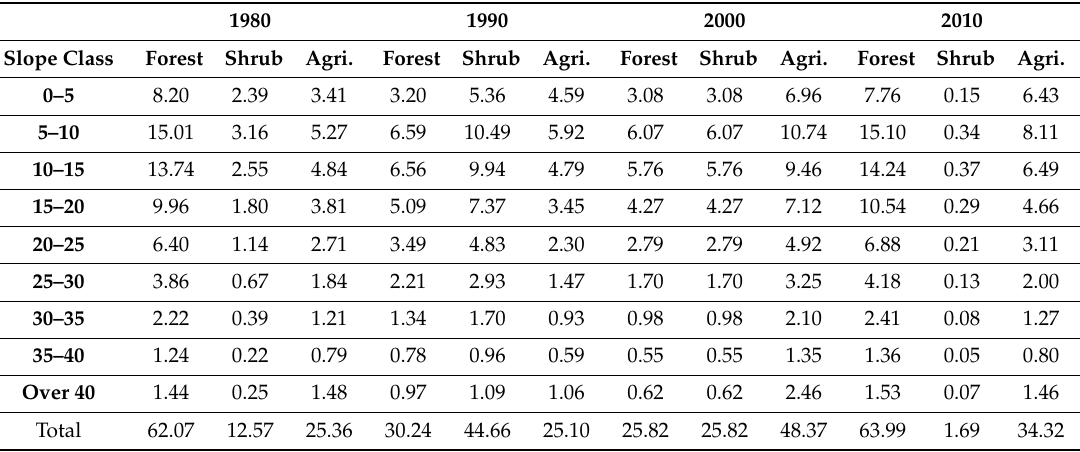
Table 9. Province 3: land use as a percentage of total area of forest, shrubland, and agriculture for 1980, 1990. 2000, and 2010 for entire Nepal. ((Individual land-use area for a slope class / sum of forest + shrubland + agriculture) * 100).